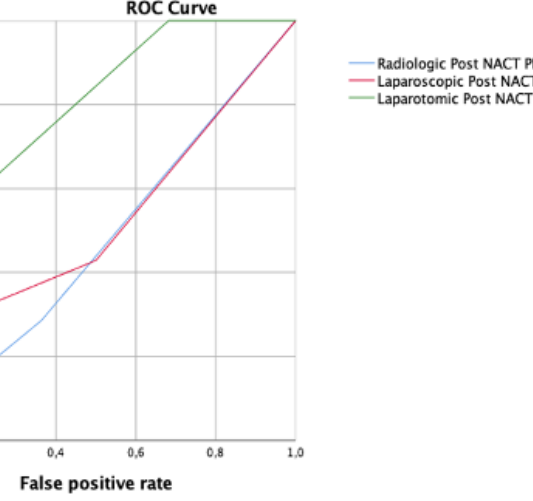
Figure 7. Receiver operating characteristic (ROC) curve comparing radiologic (blue line), laparoscopic (red line), and laparotomic (green line) predictive index (PI) modified for interval debulking surgery.